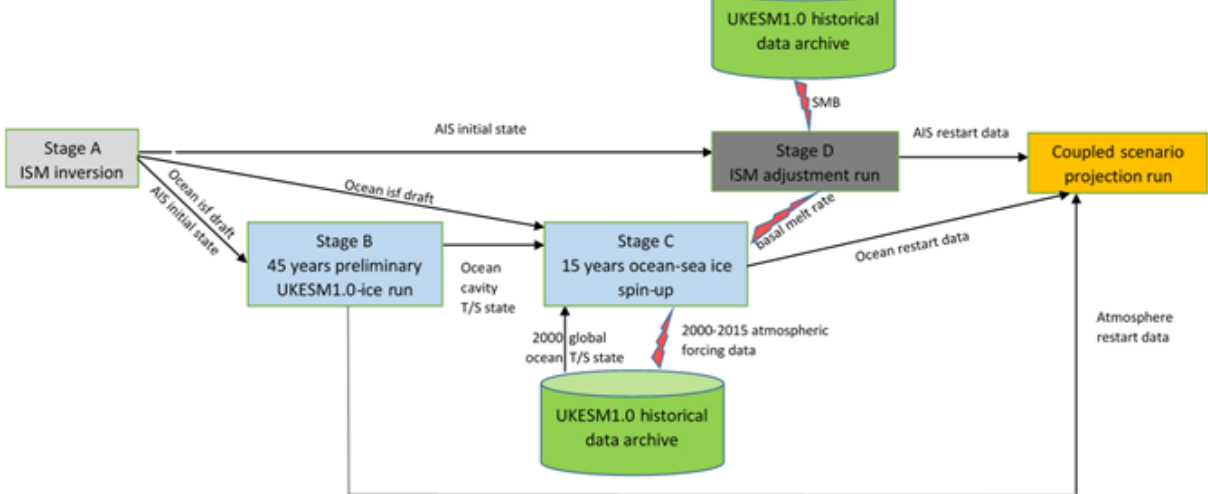
Figure 1. Stages in developing the initial condition for the coupled UKESM1.0-ice scenario projection. Blue boxes designate the two stages of ocean initialisation. Boxes with grey colours indicate the ice sheet model run: the light colour denotes a model inversion, whereas the dark colour is an ice sheet model forward run. The black arrows indicate the provision of model states, whereas the red lightning signs indicate the source of forcing